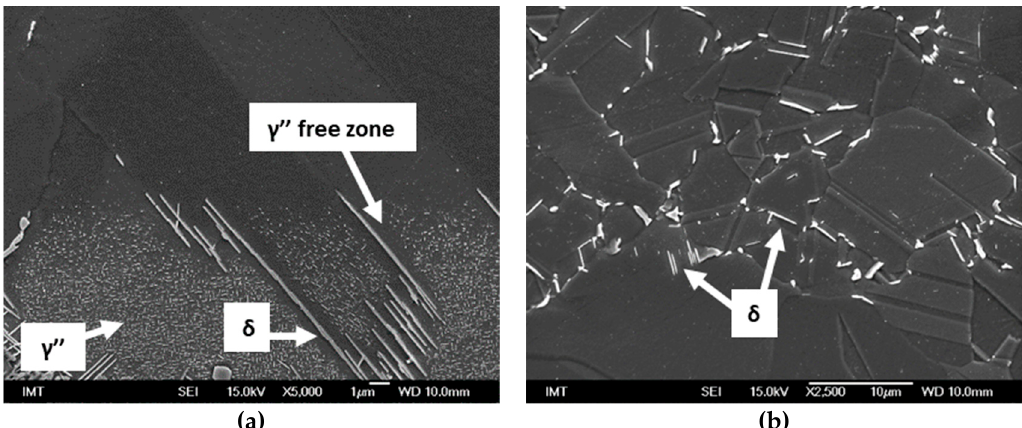
Figure 16. The precipitation of the δ phase in the transition area of the sample hot rolled at 1050 ◦ C with the deformation level of 12.7% and aged at 750 ◦ C for 25 h ( a ). Different morphology of the δ phase outside the segregation band of the sample hot rolled at 1050 ◦ C with the deformation level of 23.5% and aged at 750 ◦ C for 125 h ( b ).